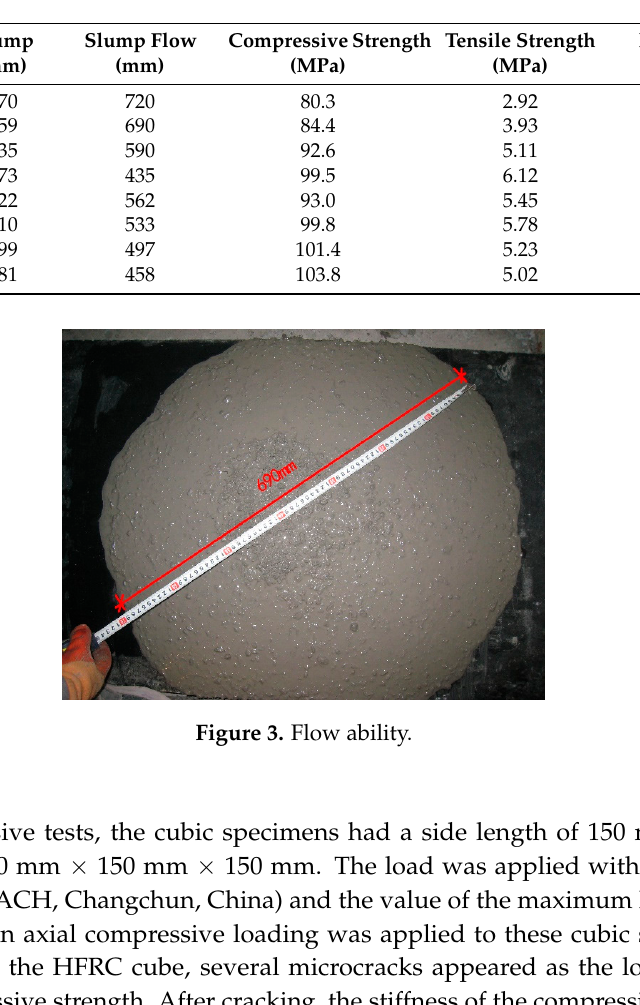
Table 3. Material test results.